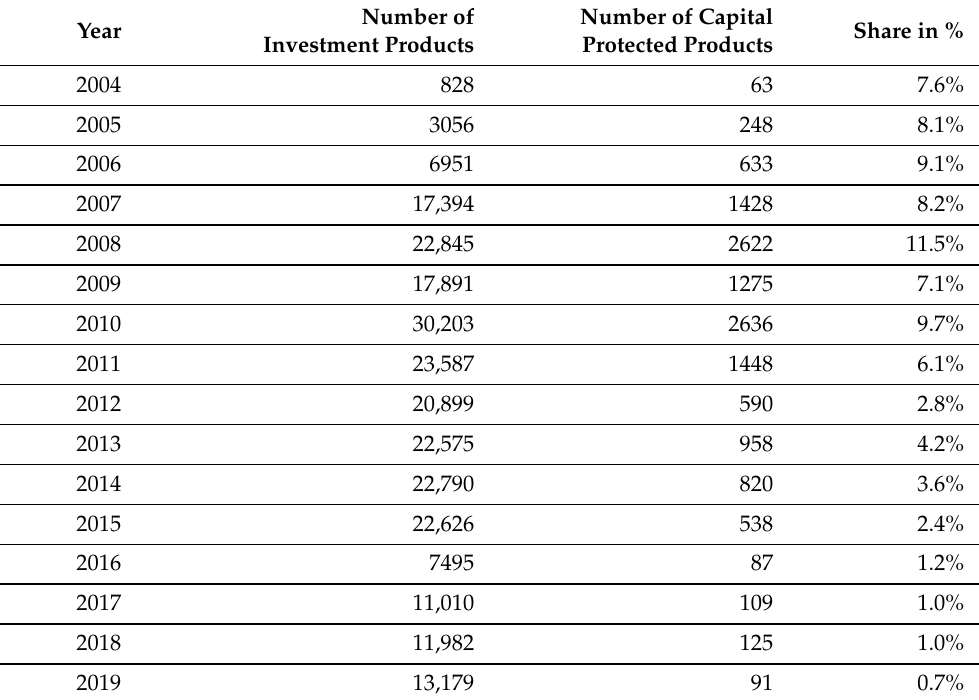
Table 1. Share of capital protected products on all investment products, 2004–2019.